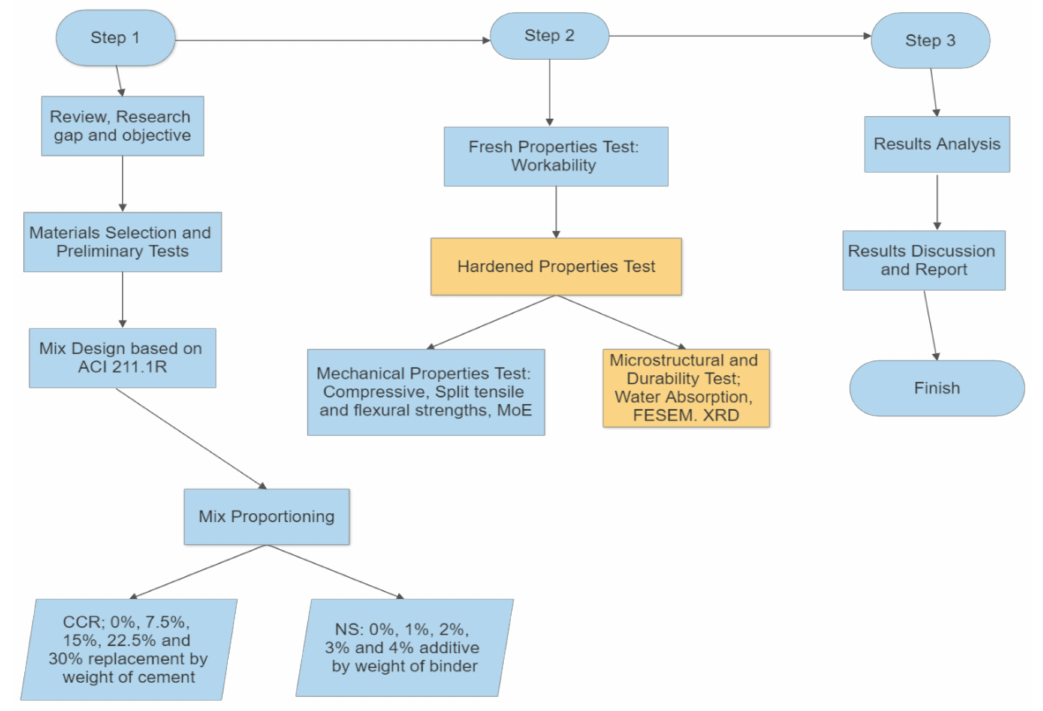
Figure 5. Flow Chart